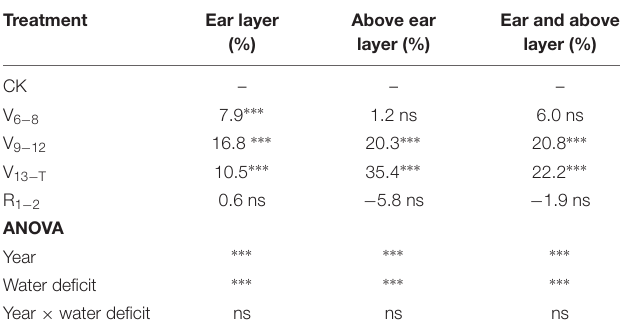
TABLE 2 | Average reduction of leaf area (%) at the ear layer, the above ear layer, and the ear and above layers around the tasseling stage that resulted from the water deficits during